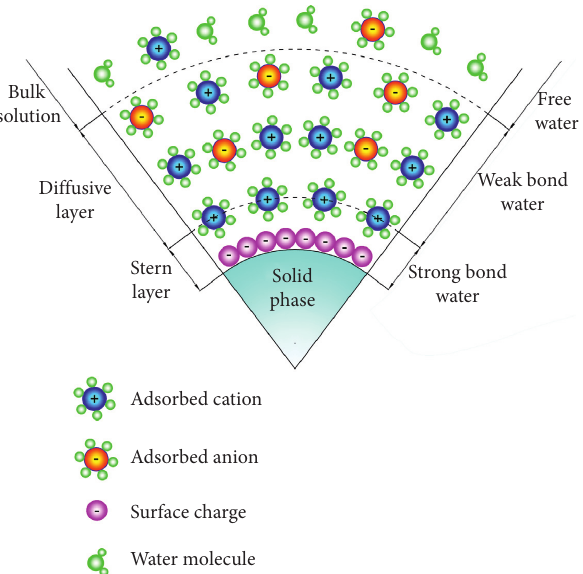
Figure 7: Schematic diagram of clay particle double electric layer